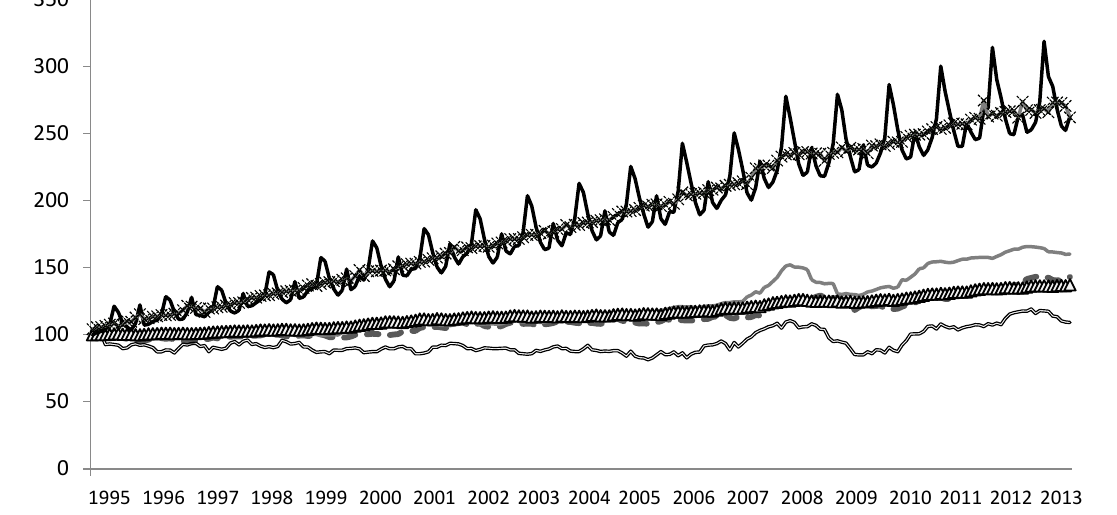
Fig. 2. Food price indices at retail (R) and producer (P) levels between 1995 and